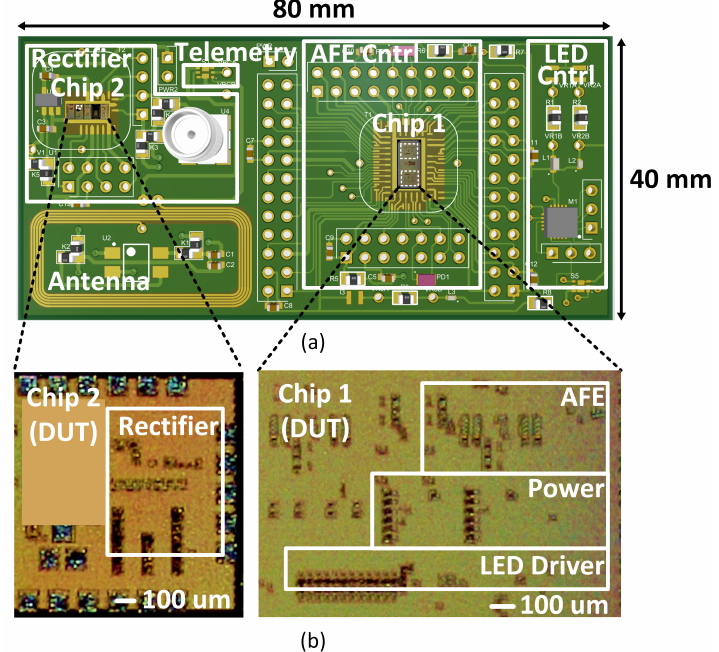
Figure 8. ( a ) Illustration of PCB with components, ( b ) micrographs of Chip 1 and Chip